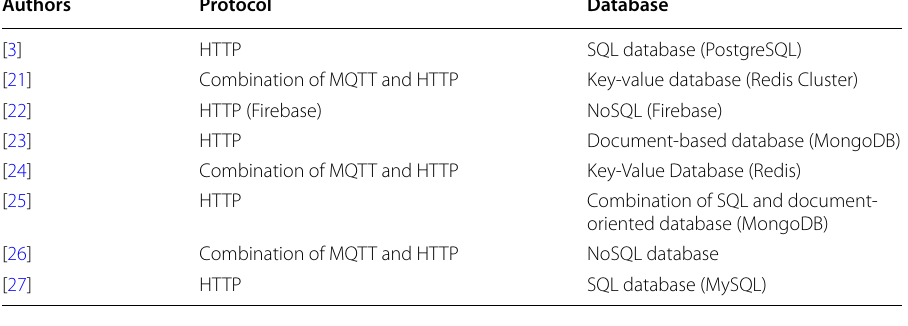
Table 1 Summary of related studies Authors